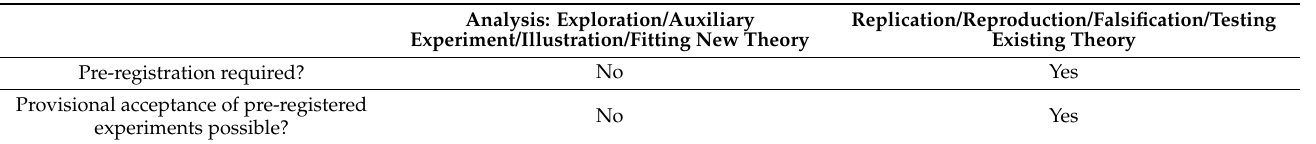
Table 1. Analysis of